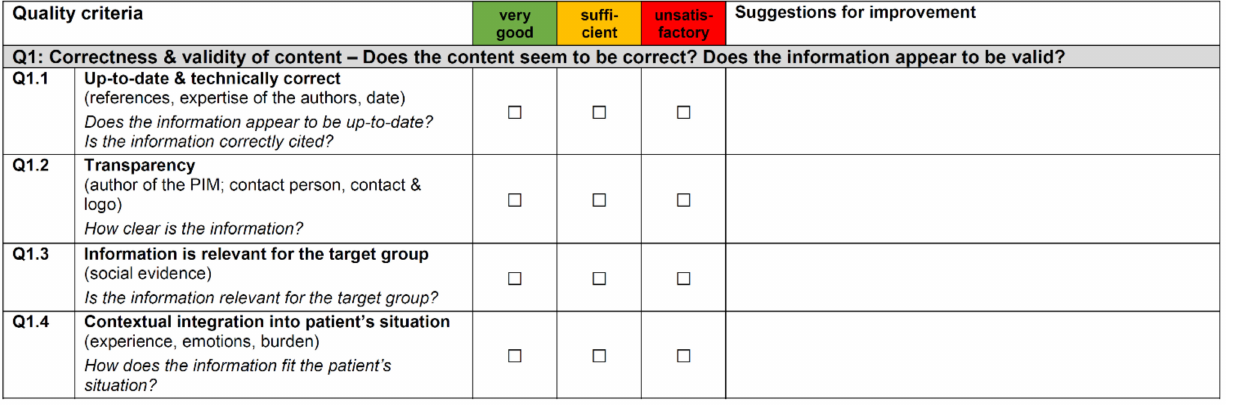
Figure 3. Excerpt from the User-Friendly Patient Information Material Checklist (UPIM-Check) English version. Available at https://www.imvr.de/wp-content/uploads/UPIM-Check_English.pdf, accessed on 18 August 2021.